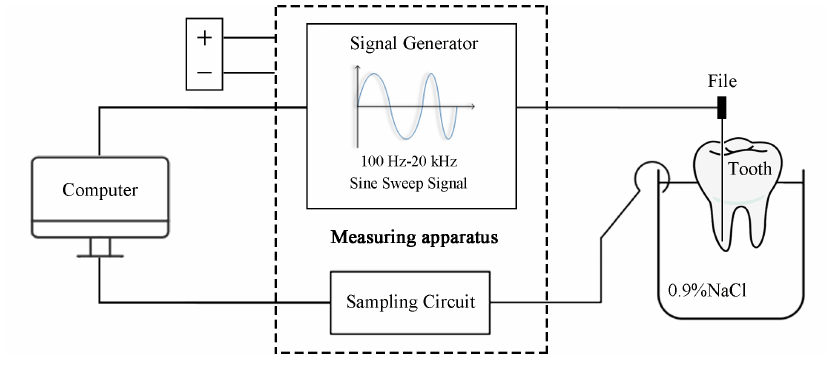
Figure 1. Diagram of the measurement process.